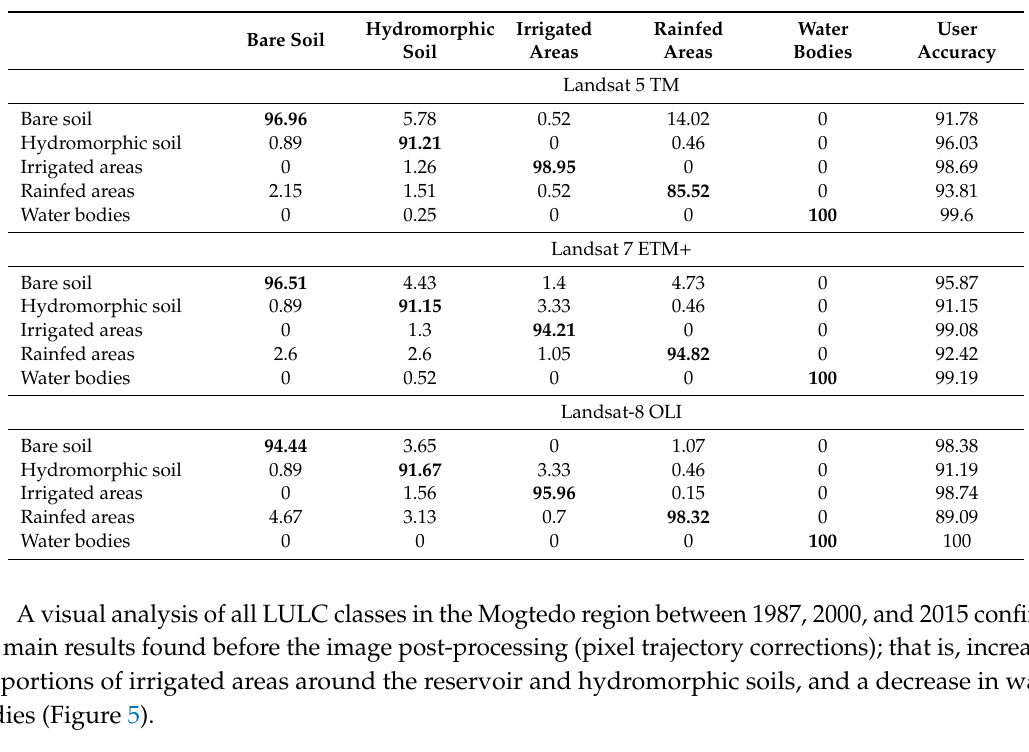
Table 6. Classification accuracy (expressed in %) after pixel trajectory corrections for each of the LULC classes in the Mogtedo region, Burkina Faso.